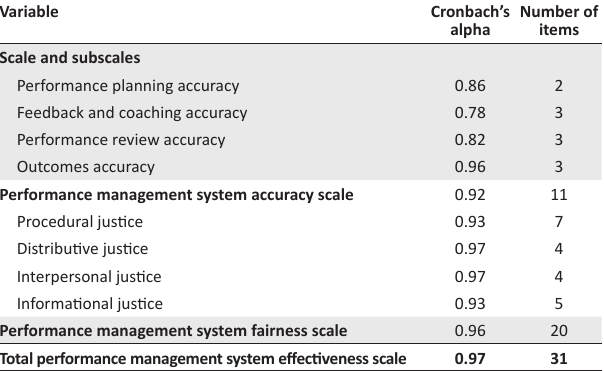
accuracy, performance management system fairness and total performance management system effectiveness